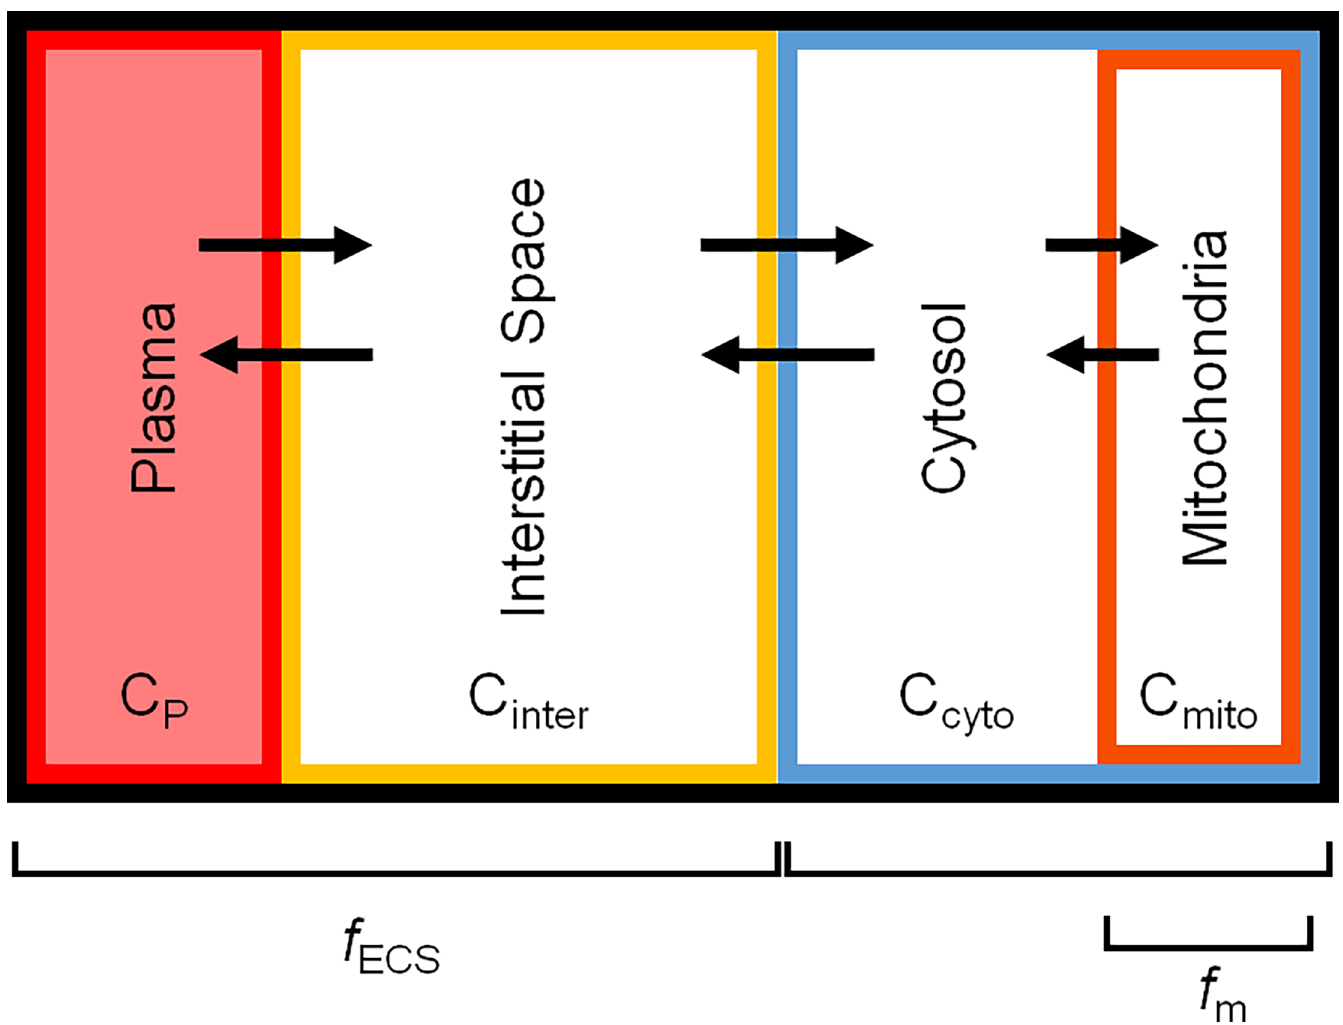
Fig 1. Volume of distribution model for 18 F-TPP + in a PET image voxel. The outer black line represents the voxel boundary. C p , C inter , C cyto , and C mito represent the concentrations of the plasma, interstitial space, cytosol, and mitochondria respectively. The arrows represent 18 F-TPP + transport between the different compartments. f ECS represents the voxel volume fraction occupied by ECS and f mito represents the cellular volume fraction occupied by